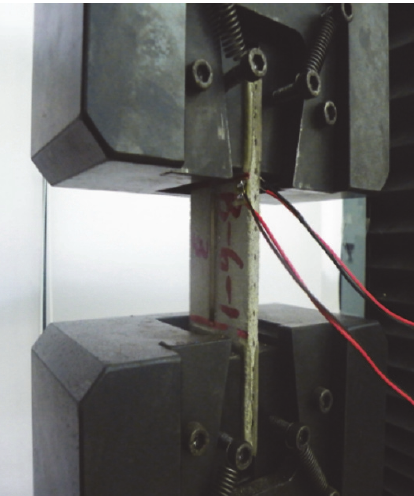
Figure 2: Tensile test of thin plate.